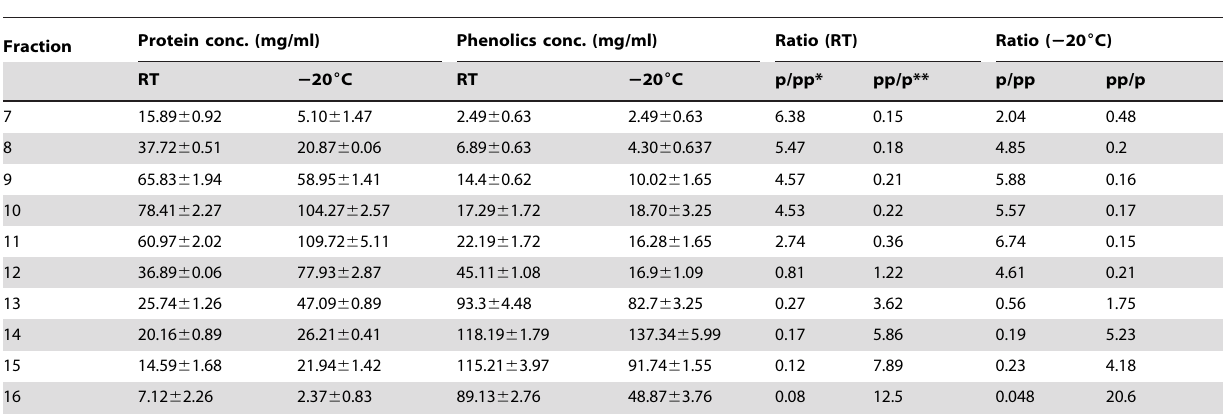
Table 4. The ratio of protein to polyphenols in SEC fractions (n= 9).